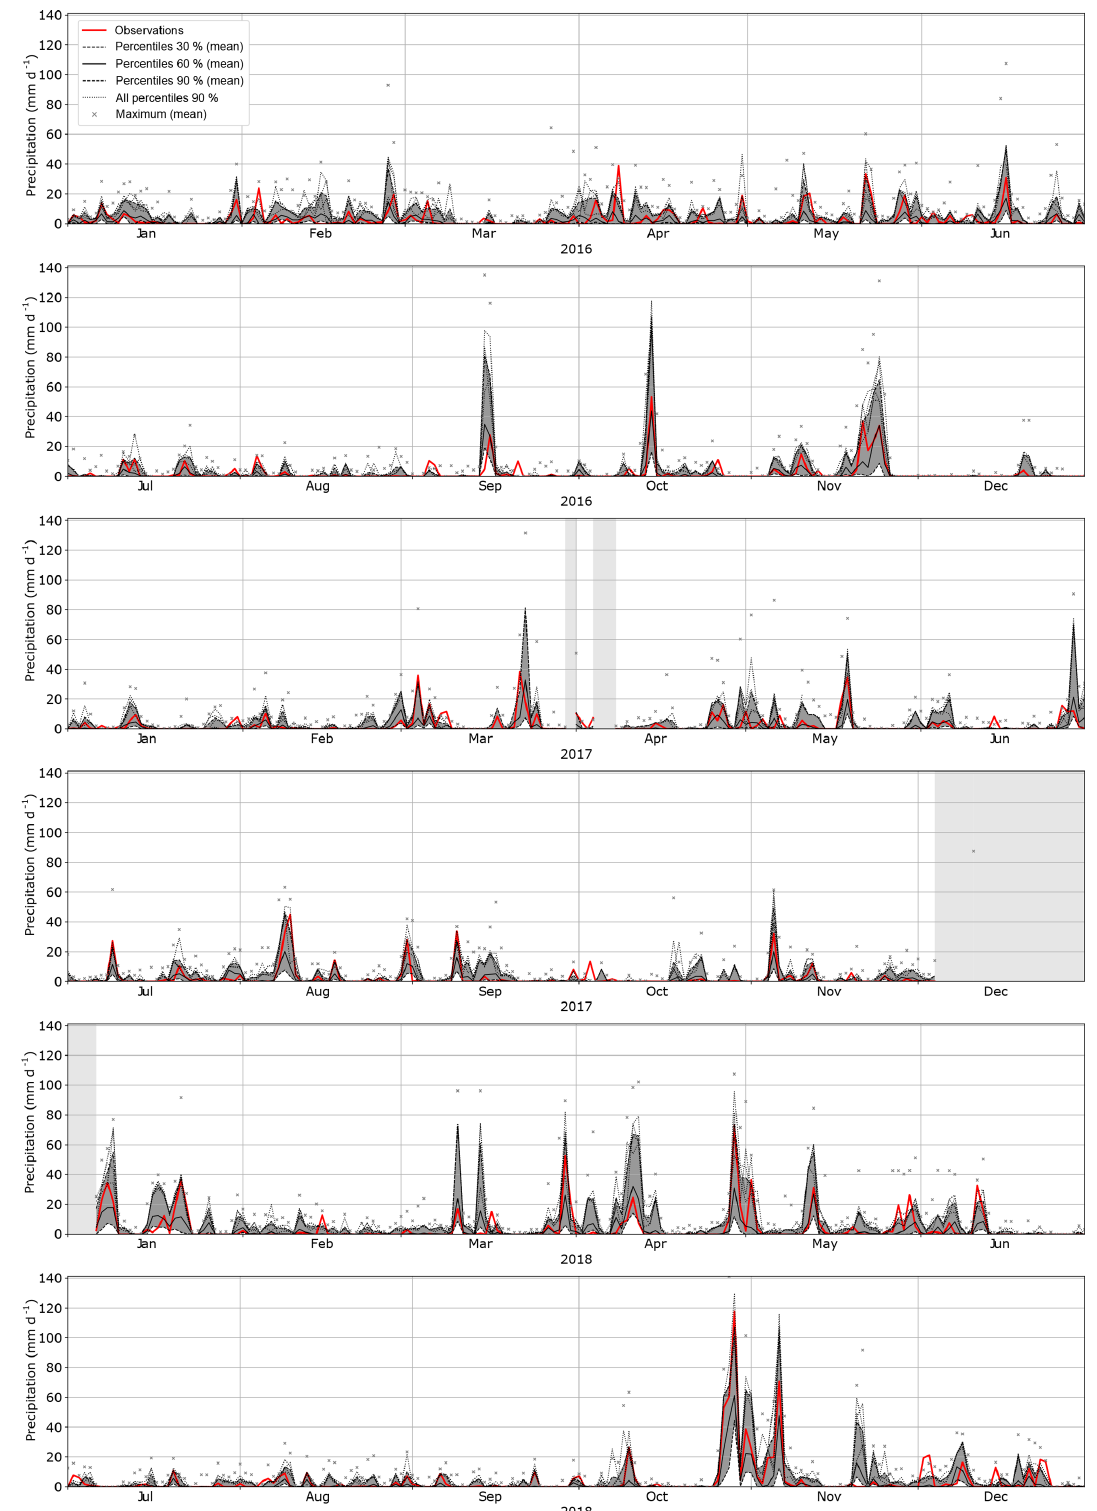
Figure 10. Forecasts for the Binn station (Fig. 1) over the period 2016–2018 obtained using the 4Zo method (Table 2) with a lead time of 3d. The distributions provided by the analog values are summarized by the 90th, 60th, and 30th percentiles, as well as the maximum (crosses), all of them averaged over the four daily forecasts. Additionally, the four 90th percentiles were also plotted to show the consistency and variability between the four daily forecasts. The shaded areas correspond to forecast